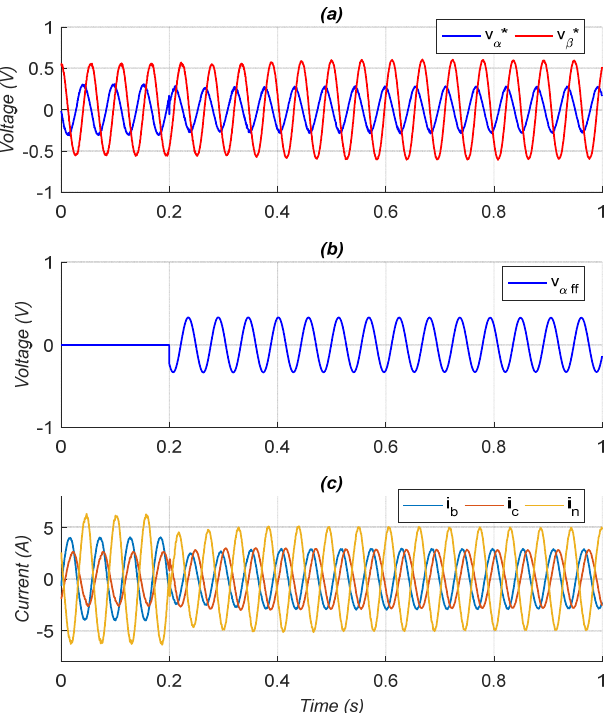
Figure 7. Postfault experimental result for the three-phase IM drive with feedforward injected at 0.2 s: ( a ) α - β voltage, ( b ) feedforward voltage, ( c ) phase and neutral current.